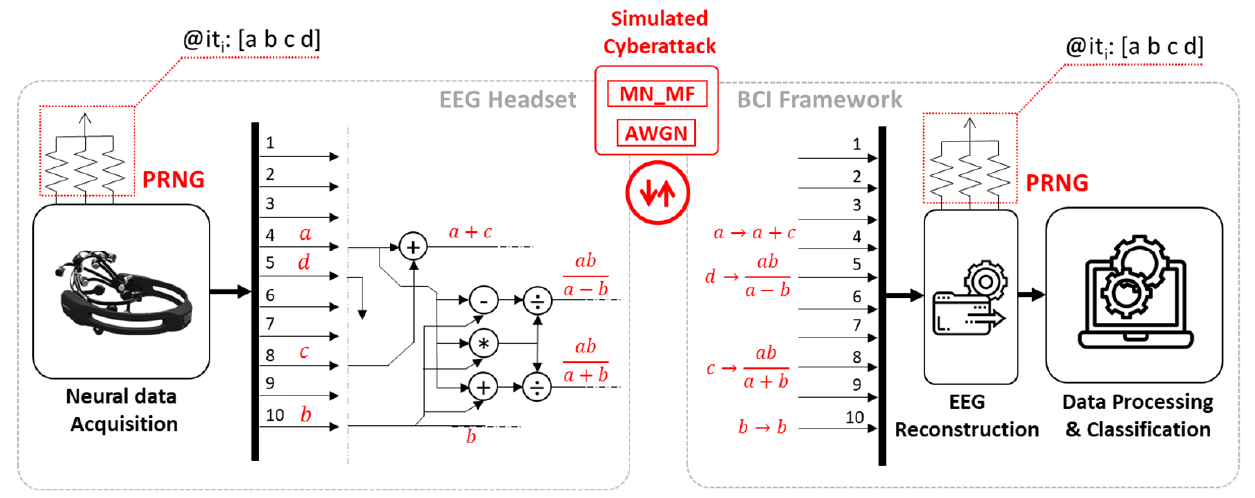
Figure 4. Architecture of a 10-channel BHR.